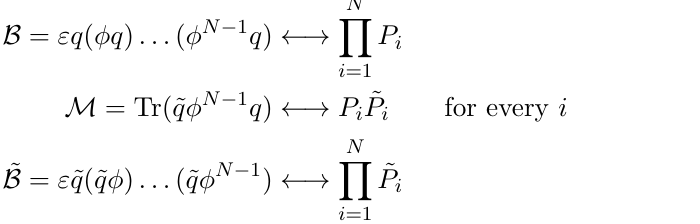
Figure 1 . On the left Z SU( N ) is